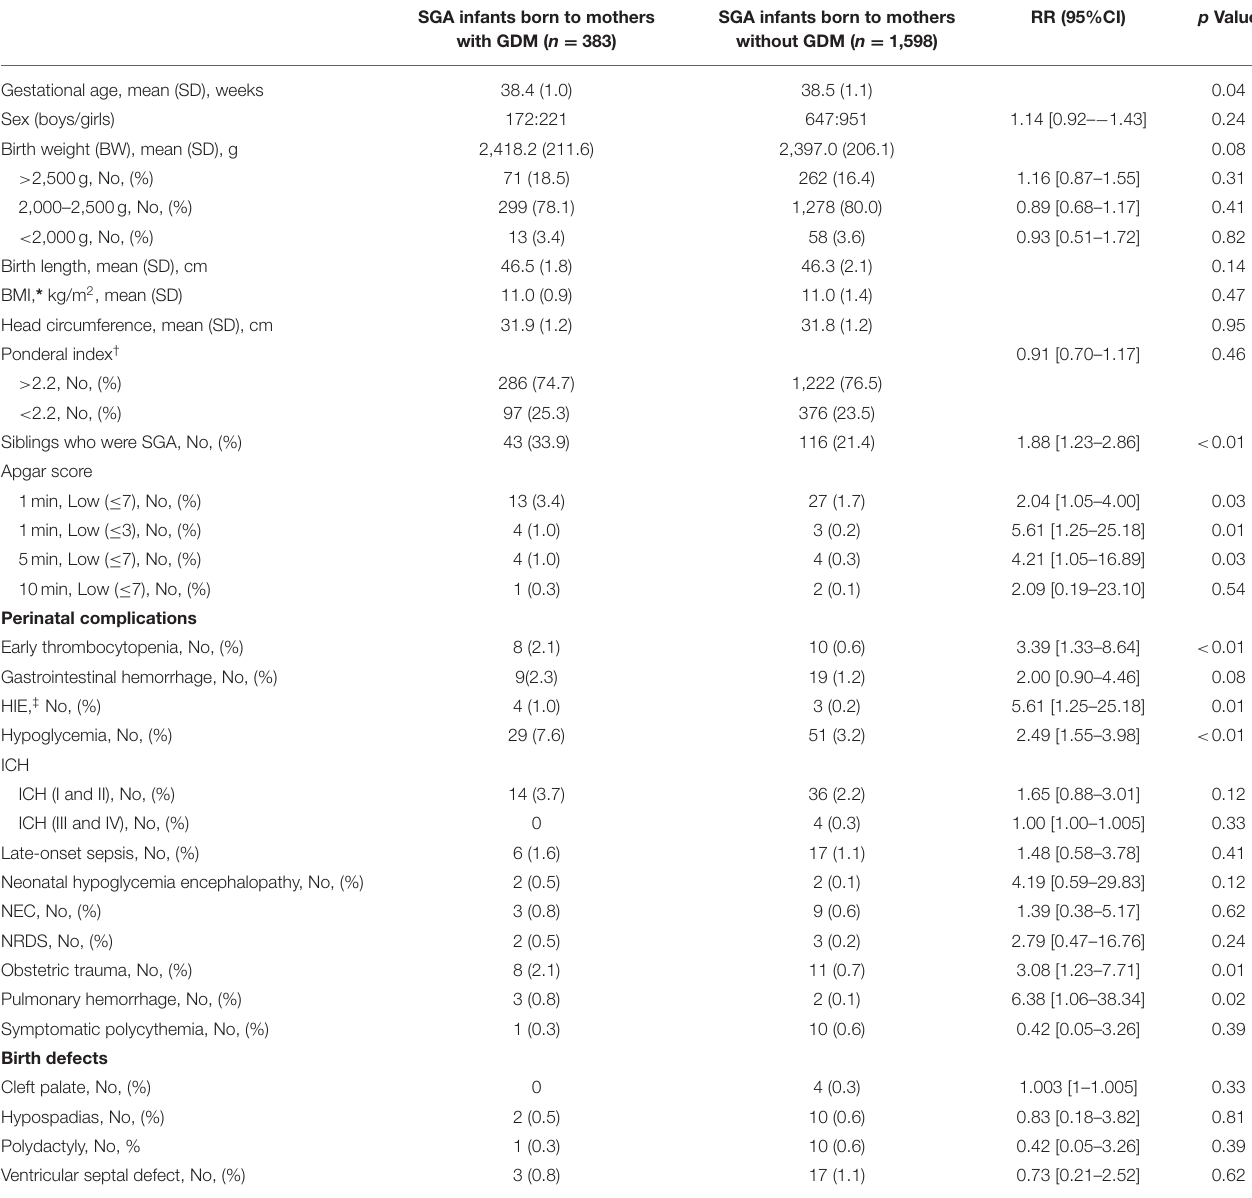
TABLE 2 | Clinical characteristics of small-for-gestational-age infants born to mothers with and without gestational diabetes mellitus ( N = 1,981).